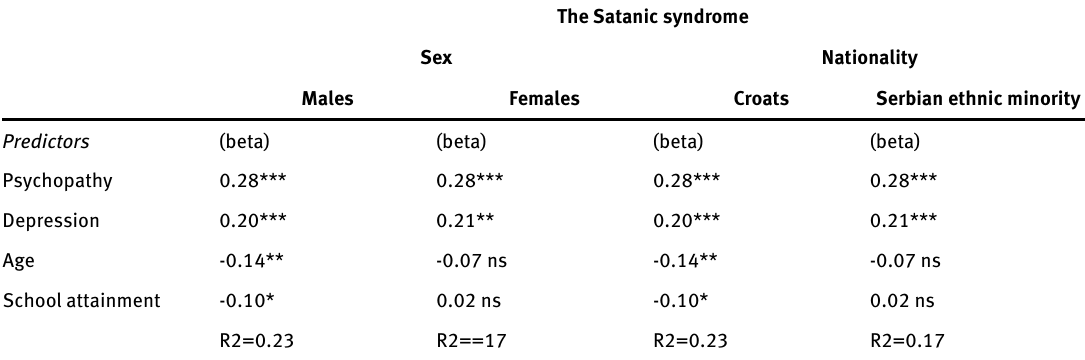
Table 7. Multiple regressions of composite variables of psychopathy and depression on the Satanic syndrome